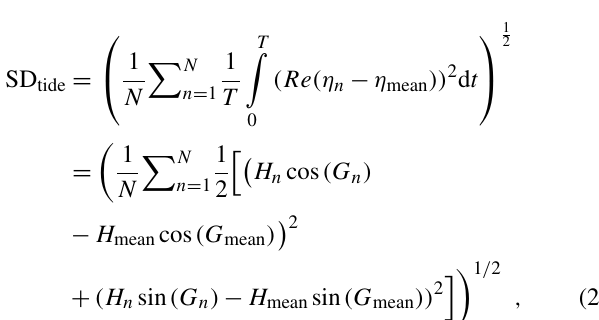
each constituent at each grid point according